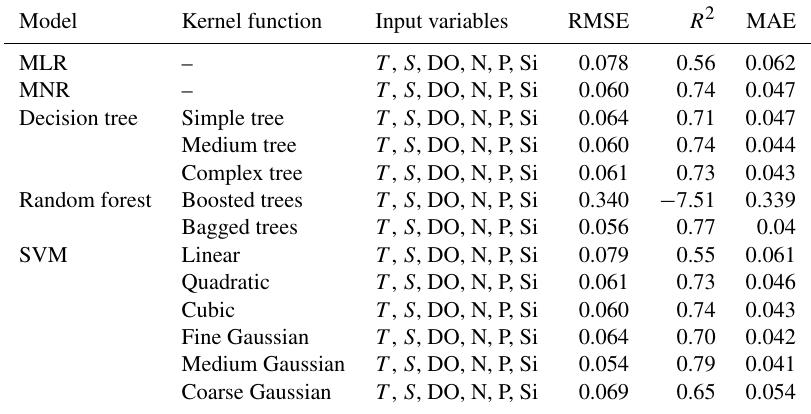
Table 3. Model comparison between traditional empirical methods (MLR and MNR) and machine-learning-based empirical methods (de- cision tree, random forest and SVM). The statistics was derived from the confirmatory dataset (training data and independent validation data) using input variables: T , S , DO, N, P and Si. Note that R 2 statistics in our study were based on the calculation of the coefficient of determination; therefore negative R 2 could be derived when there was a strong